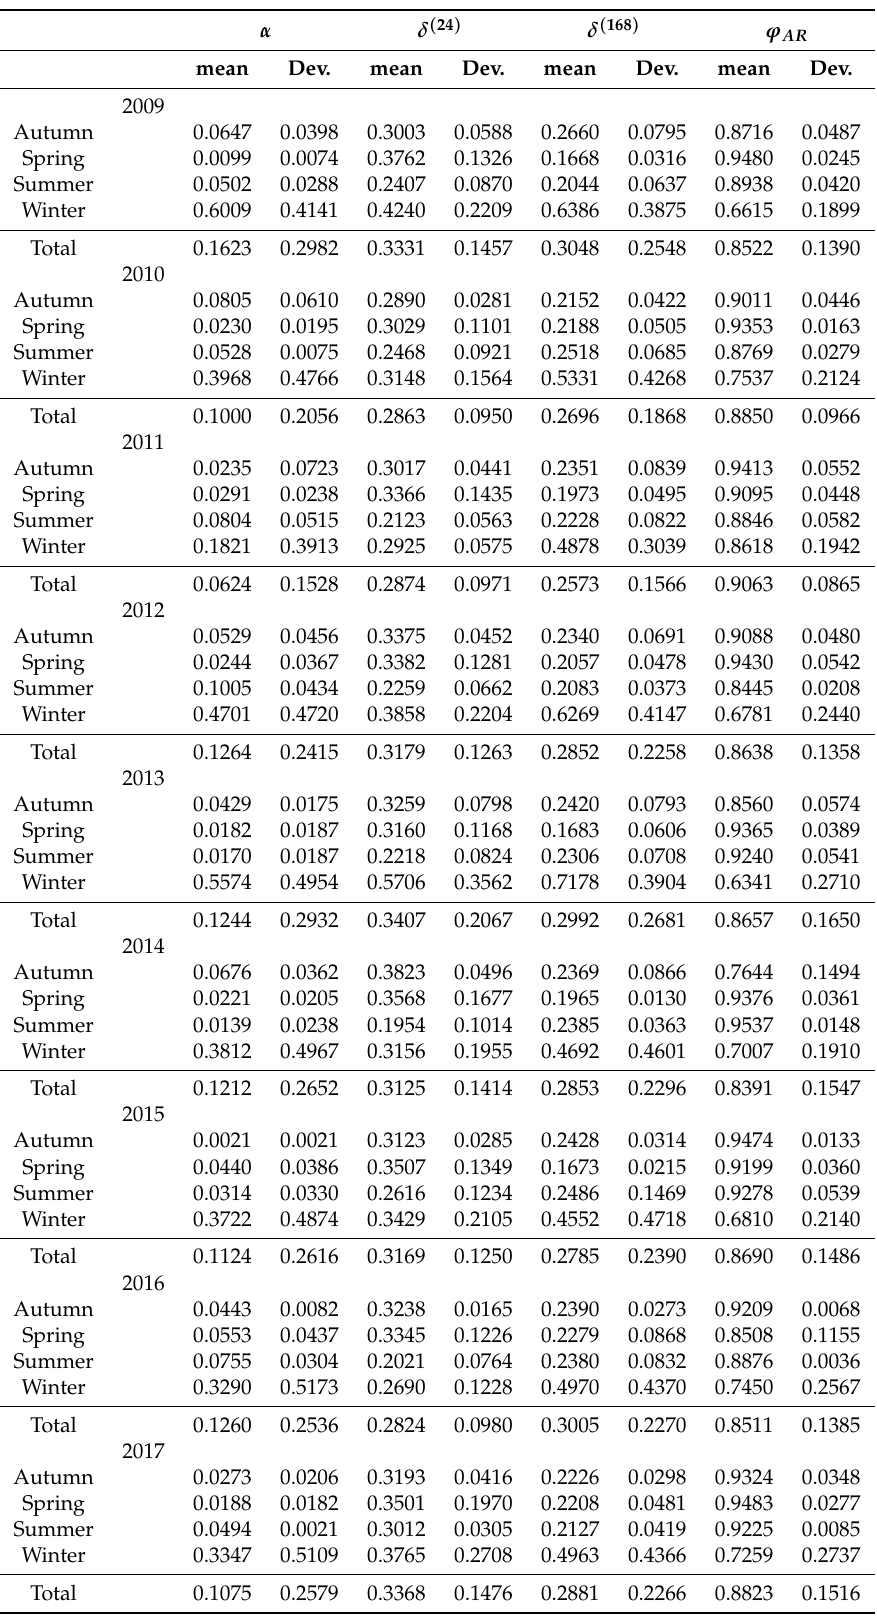
Table 3. Distribution of the parameters for the NMC 24,168